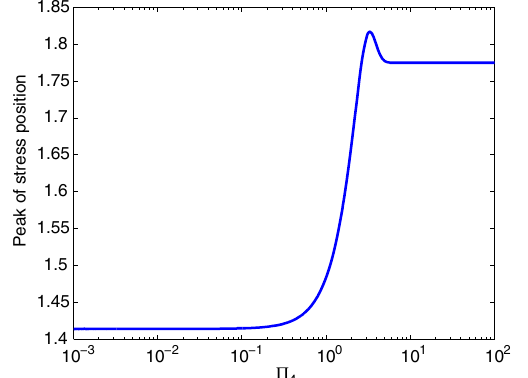
FIG. 2. ζ function as presented in Eq. (23) and its asymptotes. Since ζ is increasing with Π 4 nearly everywhere, so is the Von Mises stress. The asymptote for high values of Π 4 matches ζ expected.